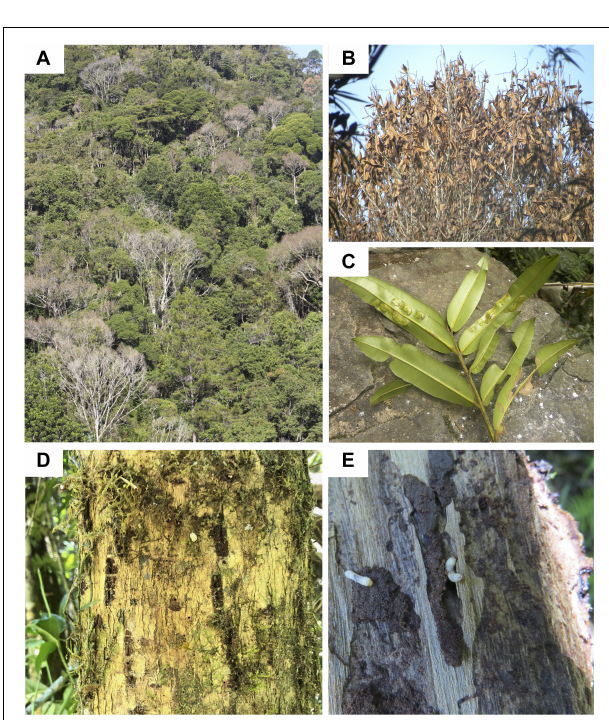
FIGURE 2 | Photos of Calophyllum trees in Ranomafana National Park, (A) landscape of forest with dead trees within the park, (B) closeup of tree with dead leaves, (C) close up of the diseased leaves, (D) the bark of a dead C. paniculatum tree with grooves perhaps caused by bark beetles, and (E) suspected bark beetle larvae in Calophyllum tree trunk.